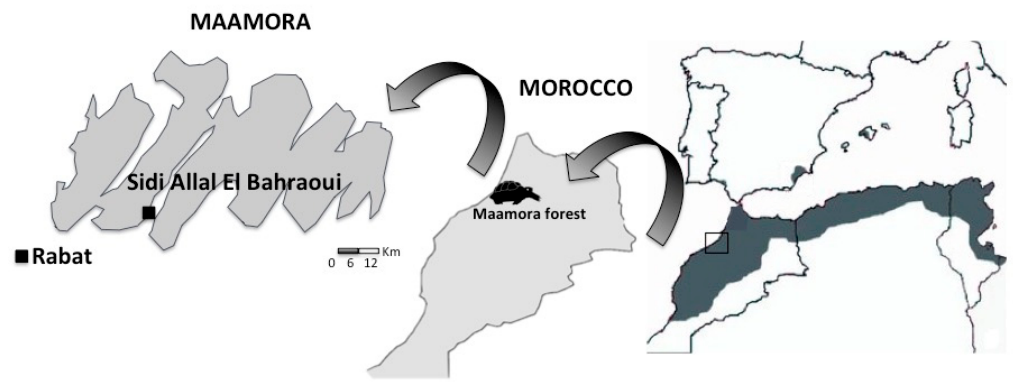
Figure 1. Distribution of Testudo graeca adapted from Gim é nez et al. [33] and location of the study